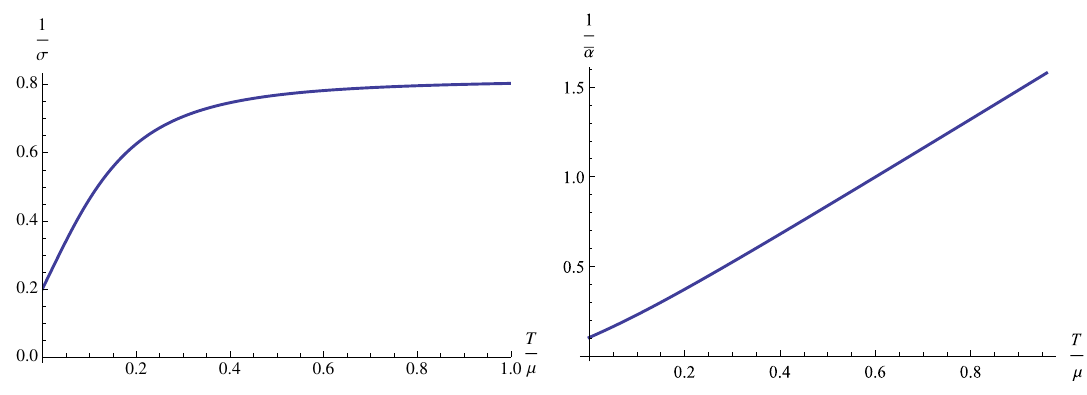
Figure 2 . Resistivites 1 =(cid:27) and 1 = (cid:22) (cid:11) as a function of the